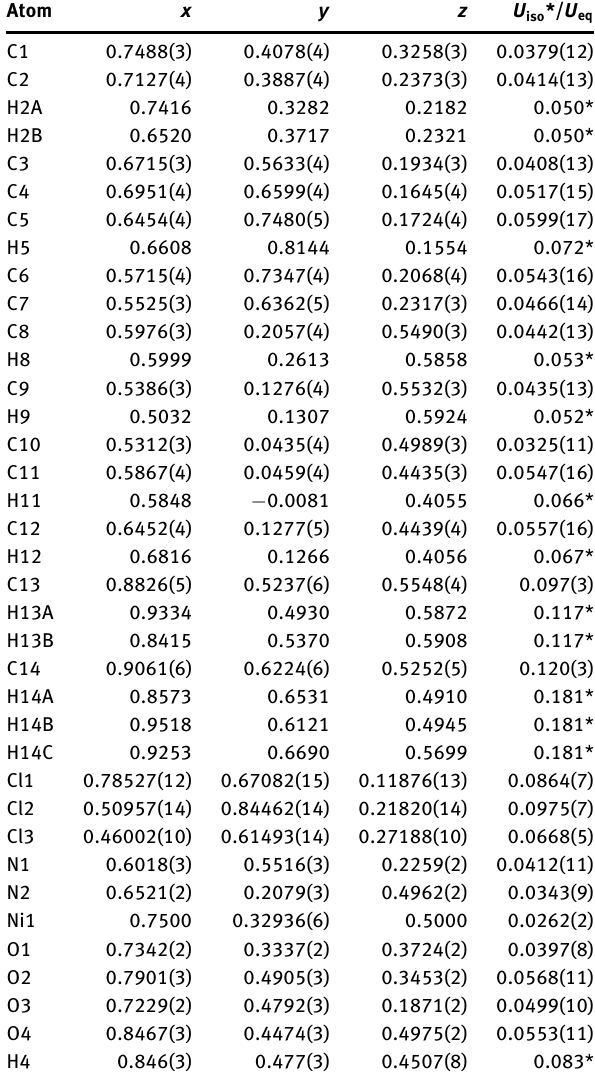
Table 2: Fractional atomic coordinates and isotropic or equivalent isotropic displacement parameters (Å 2